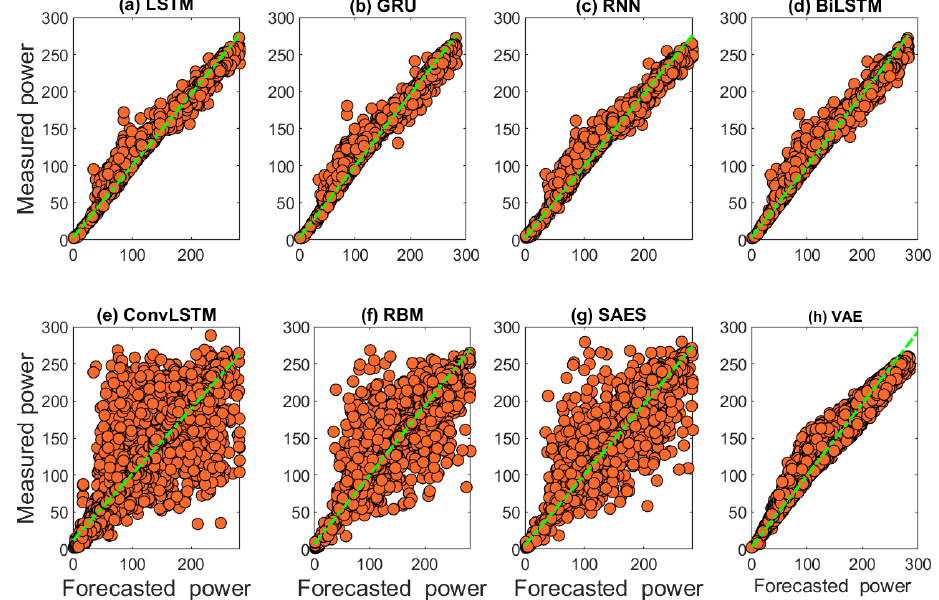
Figure 8. Scatter graphs of PV power forecasting and measurements using the eight models: ( a ) LSTM, ( b ) GRU, ( c ) RNN, ( d ) BiLSTM, ( e ) ConvLSTM, ( f ) RBM, ( g ) SAE, and ( h )